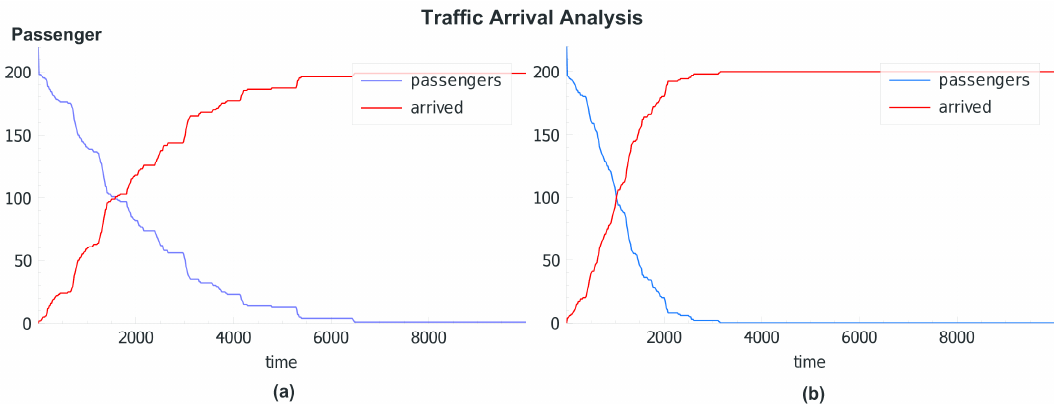
Figure 14. Simulation with 200 vehicles with static traffic control showing the accumulated number of moving vehicles/passengers and the number of arrived vehicles/passengers ( Left ) t 1 /t 0 =500/60 signal change times ( Right ) t 1 /t 0 =200/60.